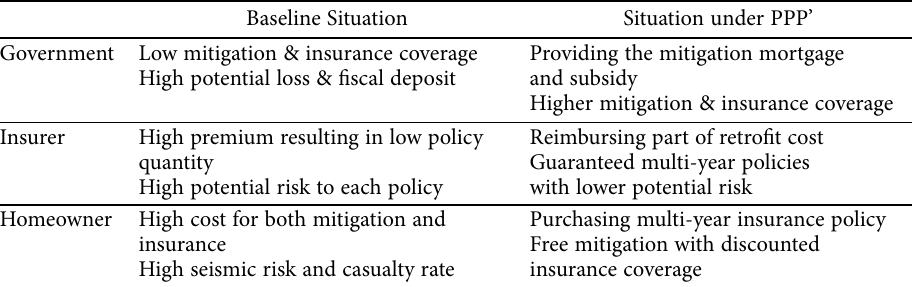
Table 1. Cost-benefit comparison for participating